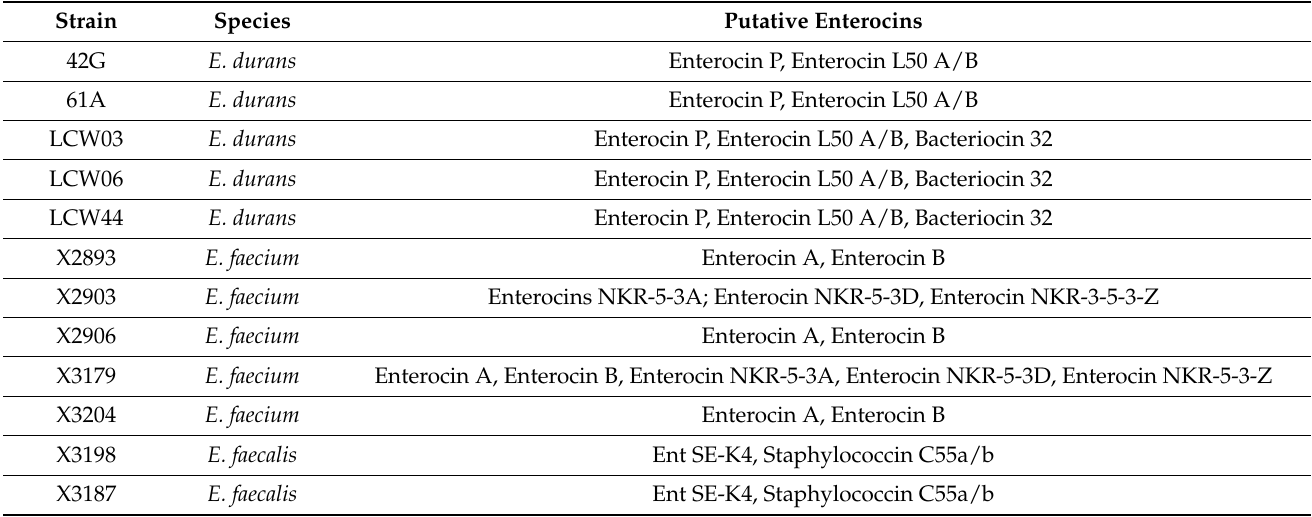
Table 3. Putative enterocins detected by WGS in the 12 selected BP+